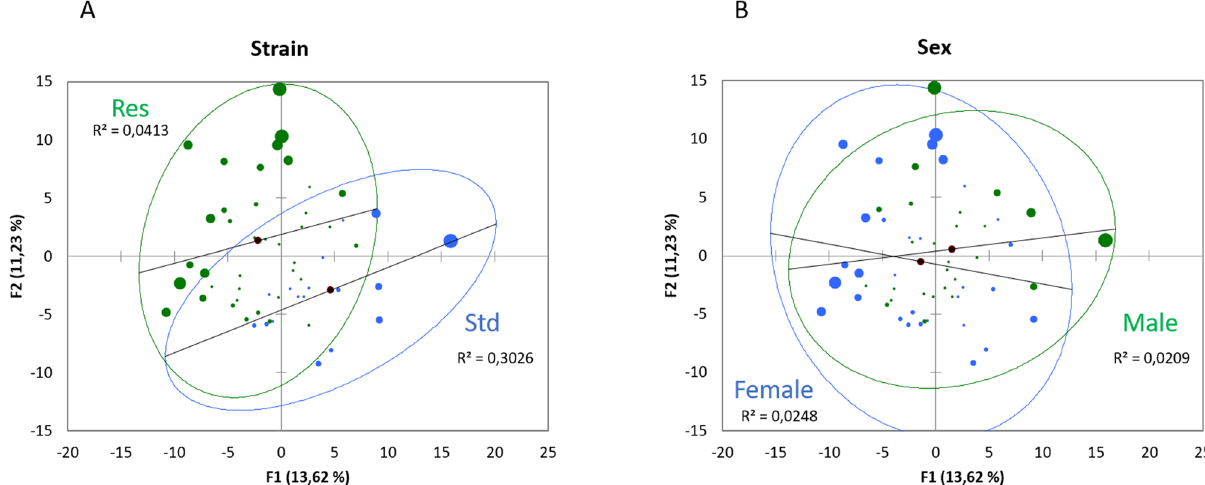
Figure 1. Principal component analysis (PCA) plot of fecal metabolome as function of ( A ) strain (Std and Res) or ( B )